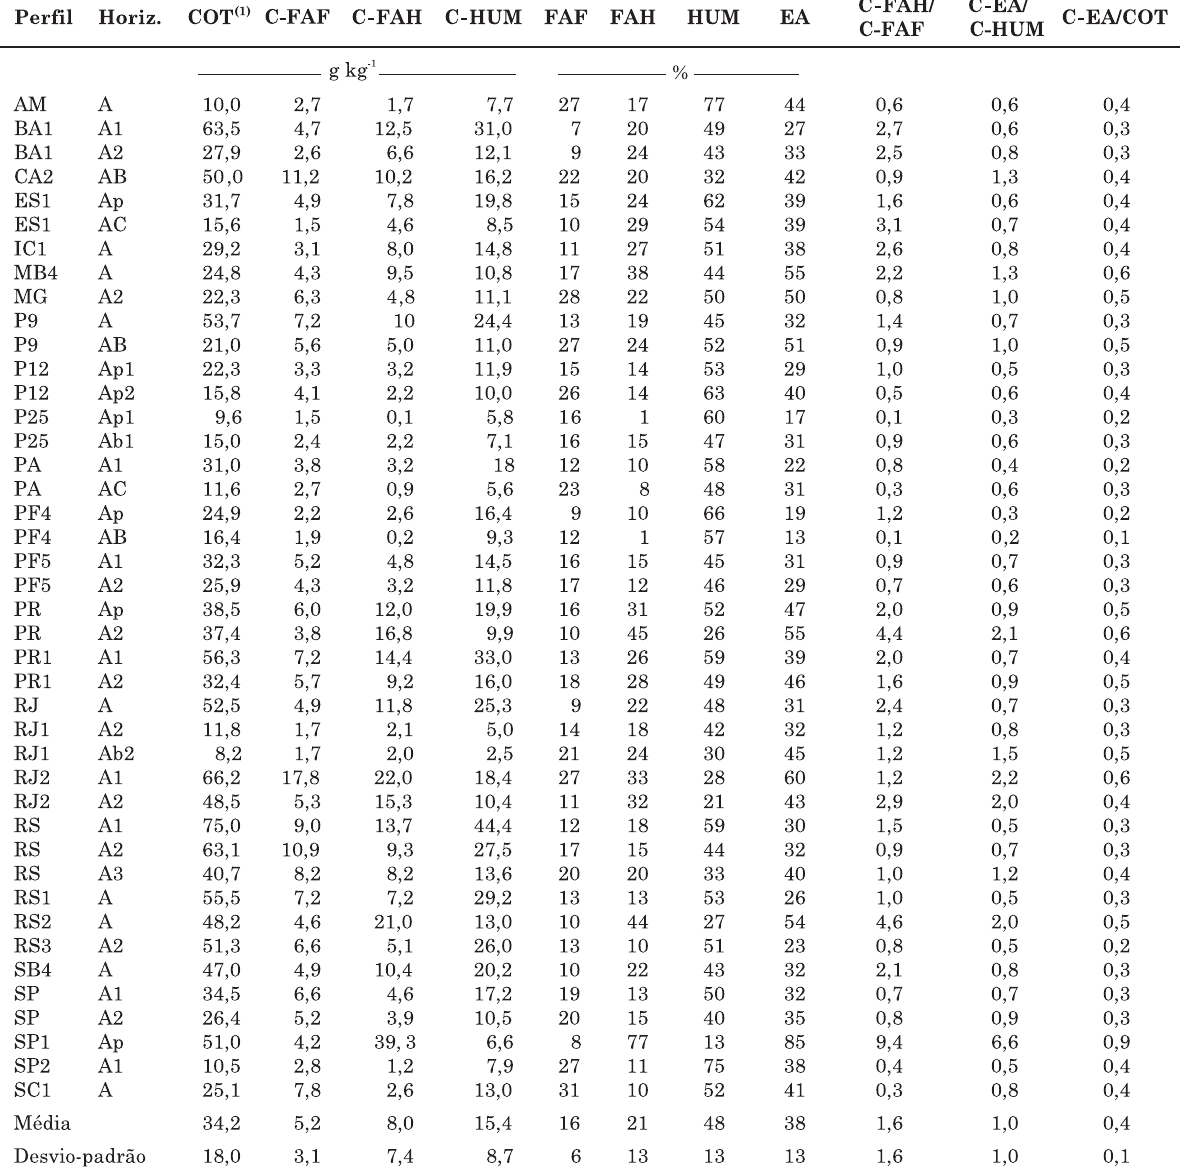
11,2 g kg -1 . Diferindo dos outros horizontes minerais, verificou-se predomínio das frações alcalinossolúveis: ácidos húmicos, com média de 44 %, e ácidos fúlvicos, com 30 % (Quadro 10). Distribuição semelhante foi observada em regiões altimontanas por Benites (2002) e Schaefer et al. (2002), com predomínio dos ácidos húmicos, com média em torno de 60 %, seguidos pelos ácidos